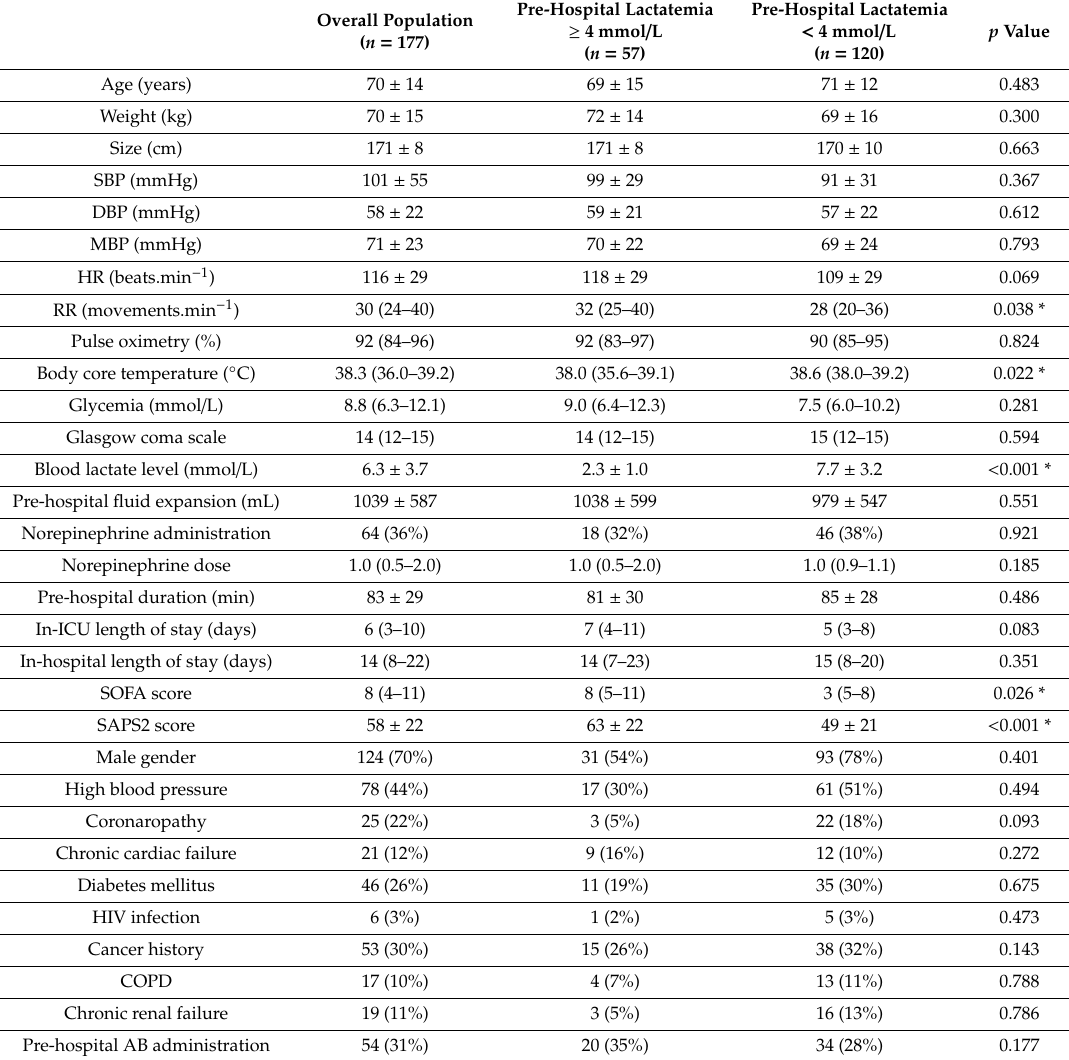
Table 3. Comparison between patients with initial pre-hospital lactatemia < 4 mmol / L and those with initial pre-hospital lactatemia ≥ 4 mmol /